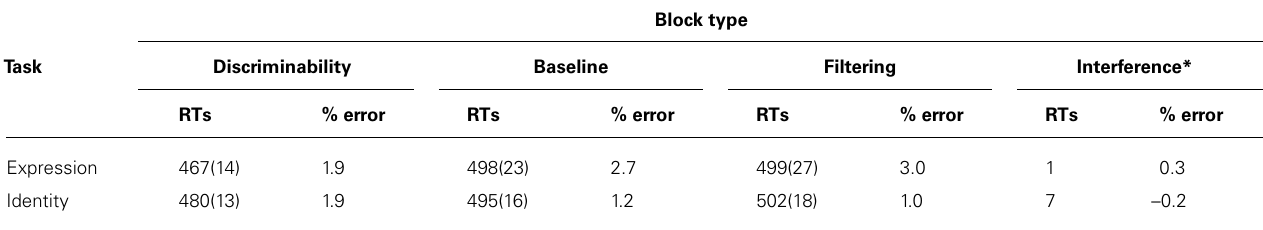
Table 4 | Mean reaction times (in milliseconds), standard errors (in parentheses), and percentages of error of performance in both identity- and expression-judgment tasks during discriminability assessment and interference measurements of Experiment 4.